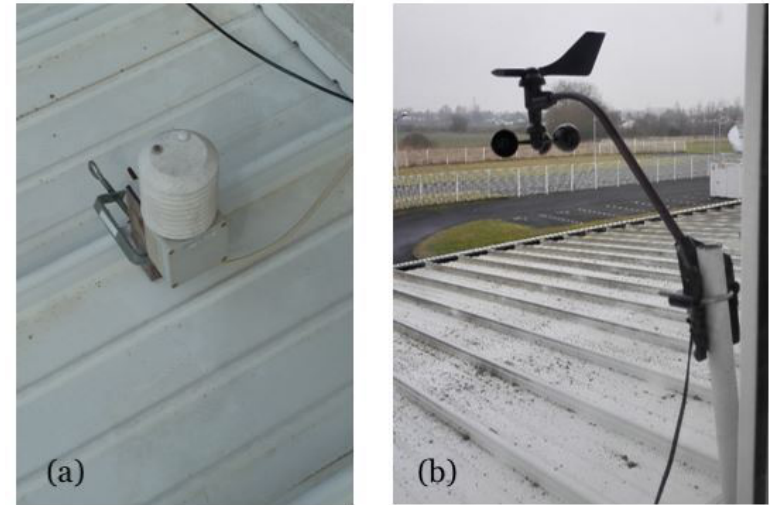
Figure 4. Sensors used to measure outside temperature ( a ) and anemometer/wind vane used to measure wind speed and direction ( b ).